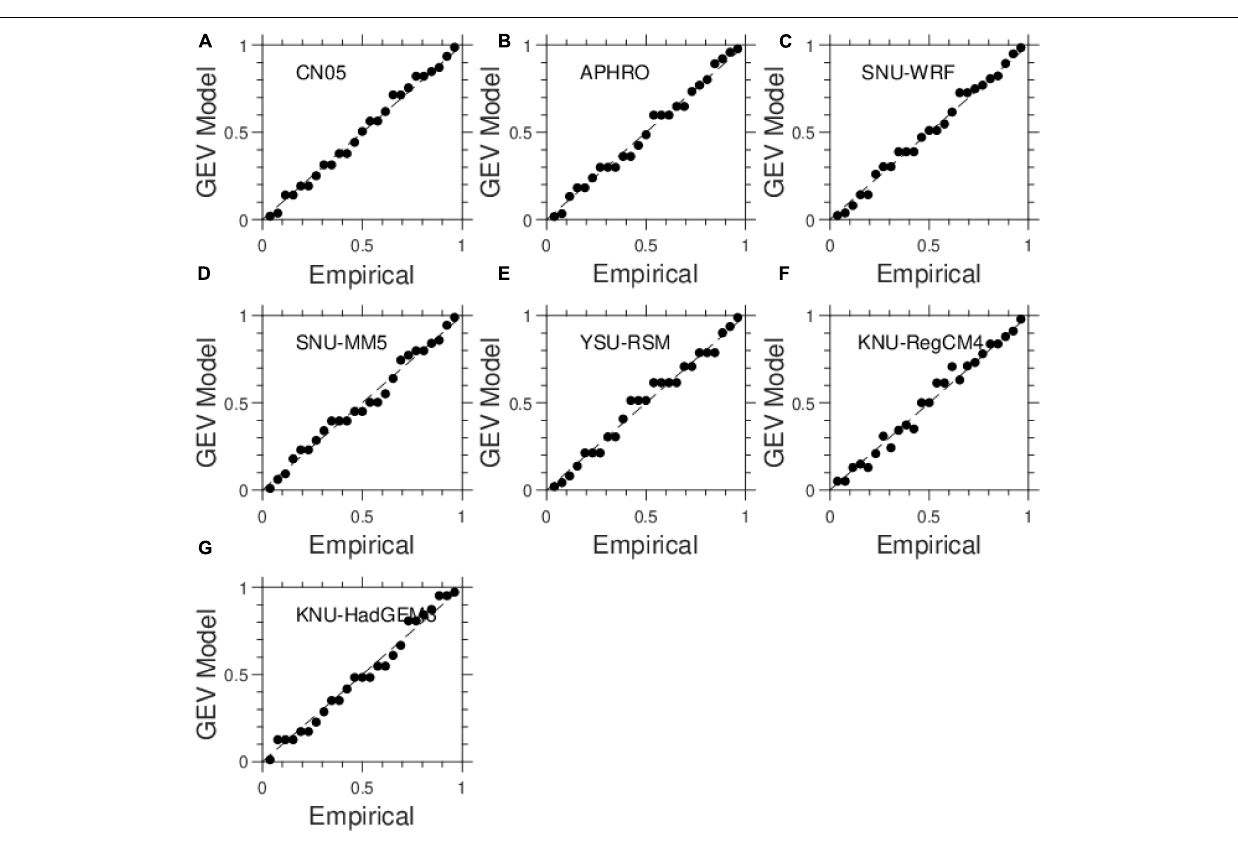
Frontiers in Earth Science |